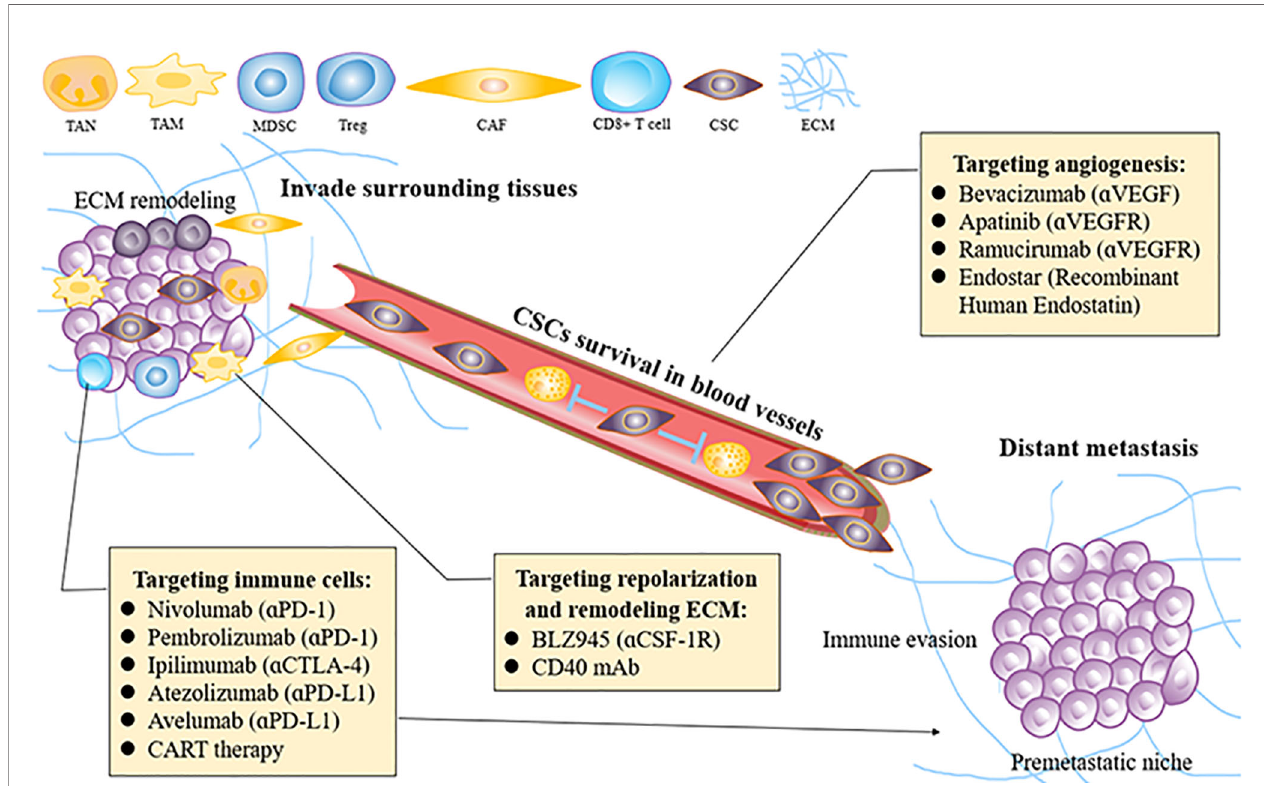
FIGURE 3 | How to re-educate the tumor microenvironment for treating ESCC invasion and metastasis. ESCC, esophageal squamous carcinoma; MDSC, mallow- derived suppressor cell; Treg, regulatory T cell; CAF, cancer associated fi broblast; VEGF, vascular endothelial growth factor; TAM, tumor-associated macrophage; TAN, tumor-related neutrophil; ECM, extracellular matrix; CSCs, cancer stem cells; PID-1, programmed cell death protein 1; CTLA4, T lymphocyte-associated antigen 4; CSF-1, colony-stimulating